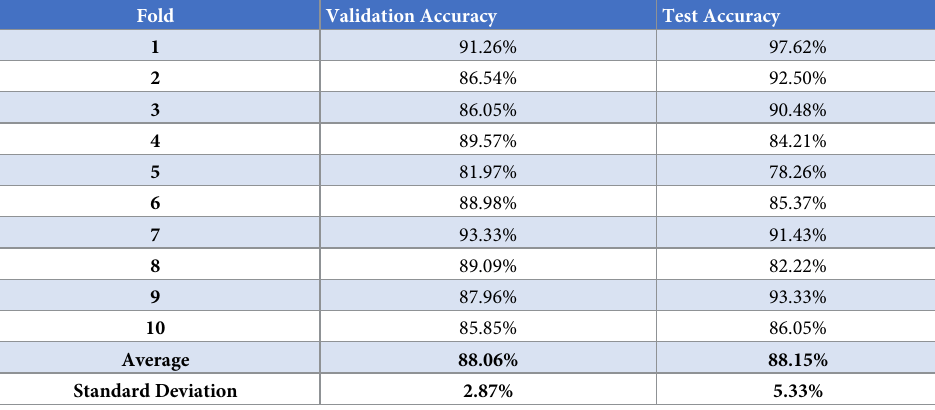
Table 2. Transfer learning validation and test accuracy values for each